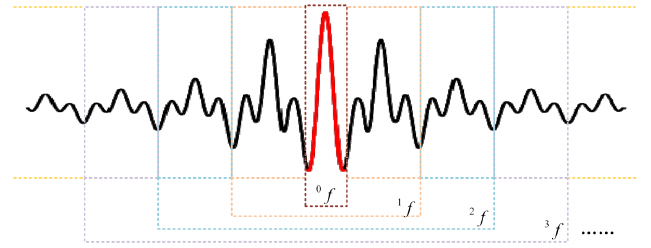
Figure 3. The relationship of pieces of piecewise extrapolation